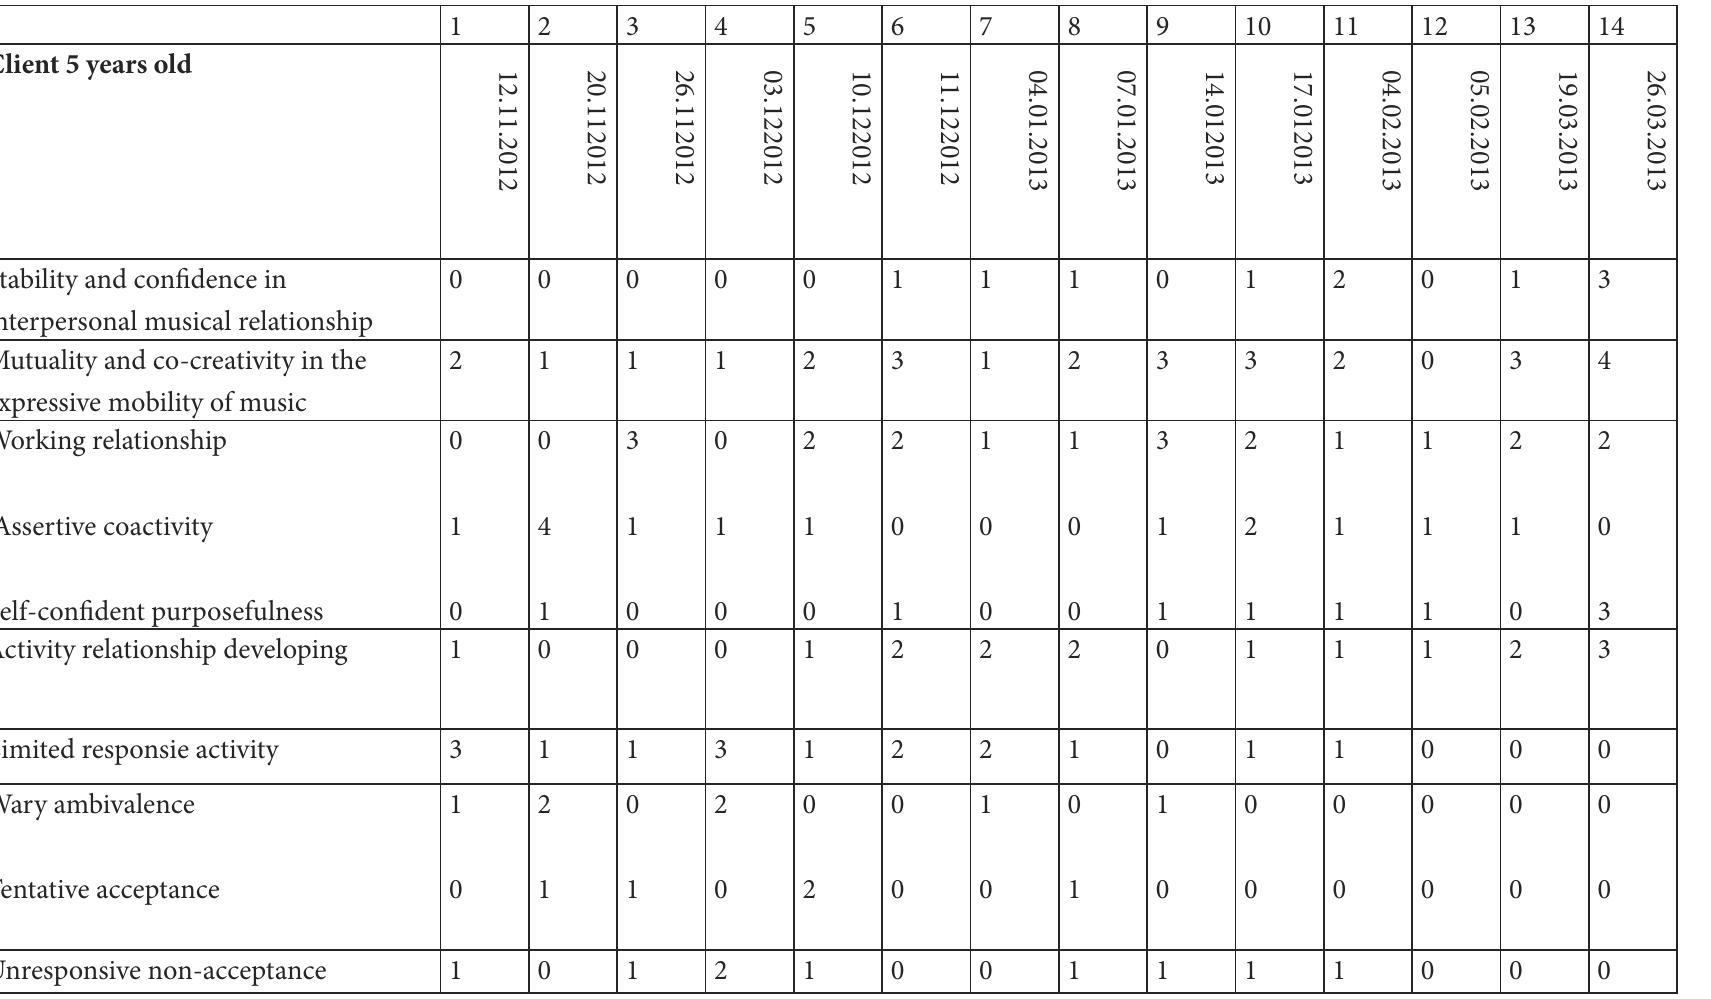
Tab. 1. Scale I Child – Therapist Relationship in Coactive Musical Experience Rating Form (a (cid:222) ve-year-old boy) Source: Own calculations and modi (cid:222) cations based on: P. Nordoff, C. Robbins (2007. p.